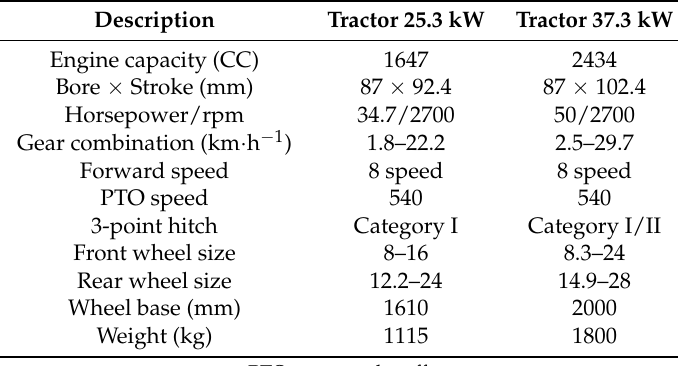
Table 1. Specifications of the tractors.